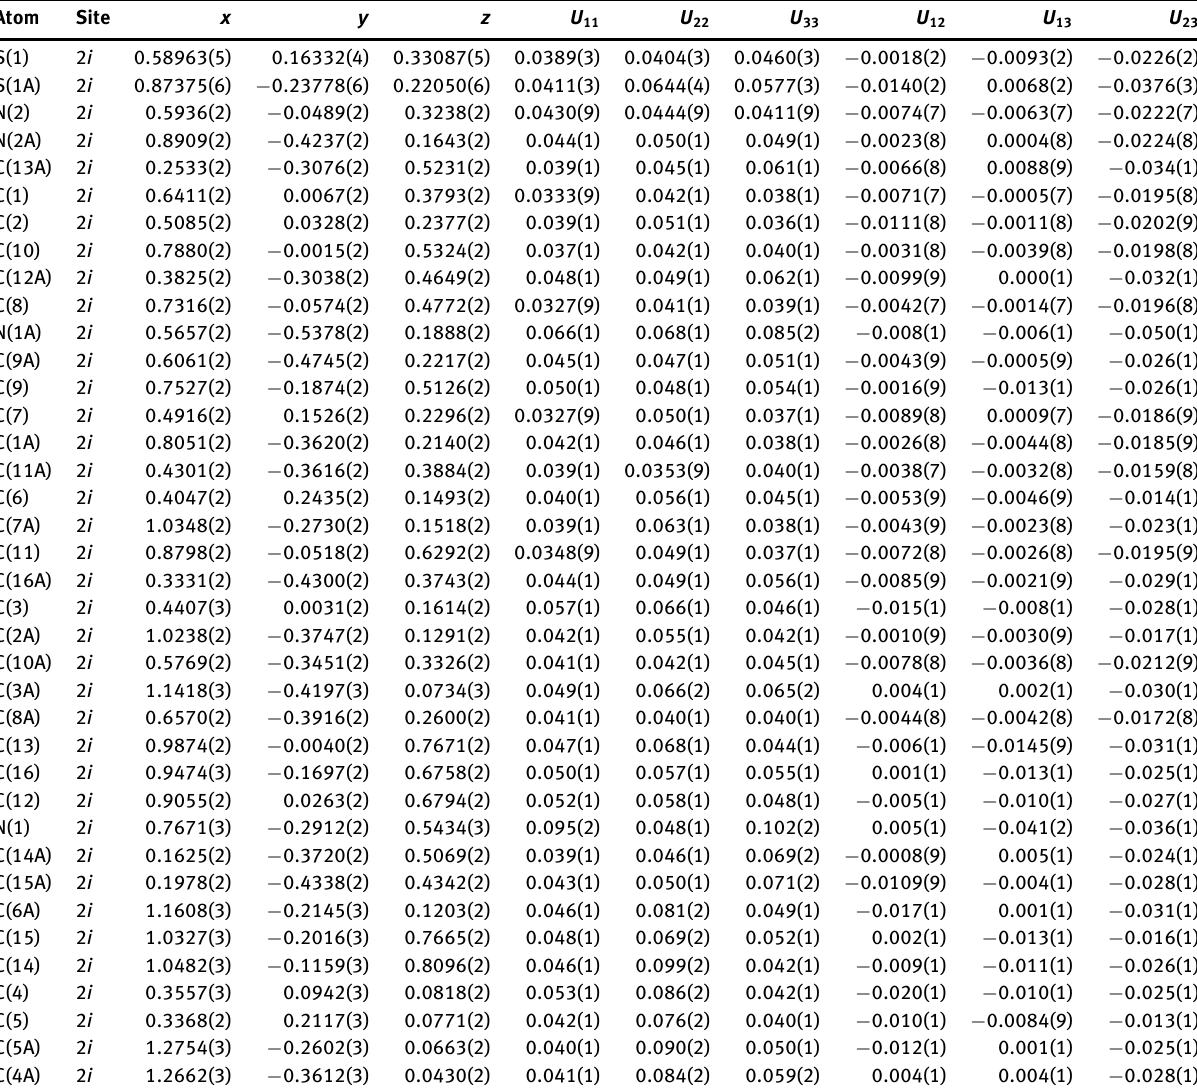
Table 3: Atomic displacement parameters (Å 2